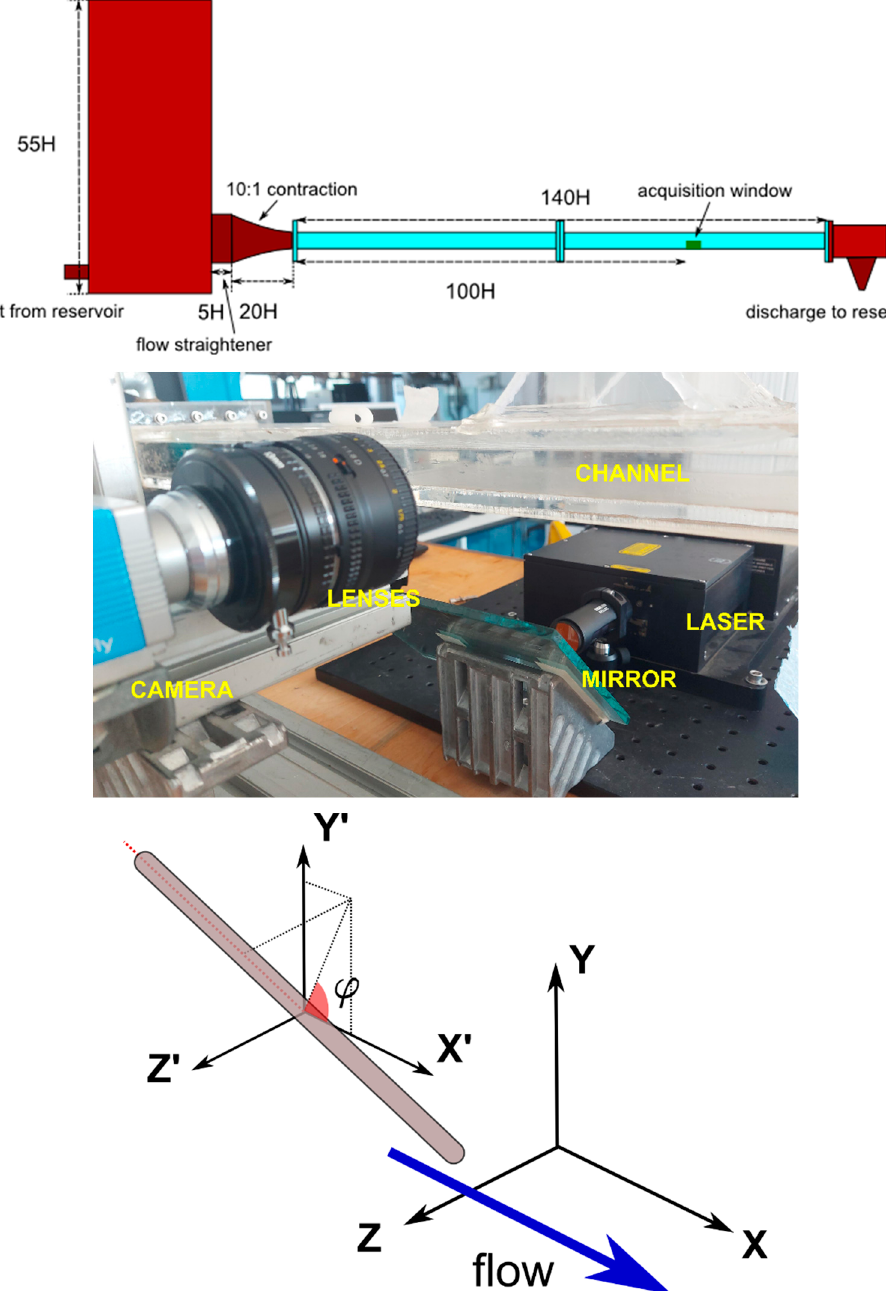
Figure 1. Schematics (top) and picture (middle) of the channel flow experimental set-up. Elements are not to scale. Representation of flow frame of reference (X, Y, Z), particle centered co-moving, non-rotating frame of reference (X ′ , Y ′ , Z ′ ) and in-plane particle orientation angle (bottom).